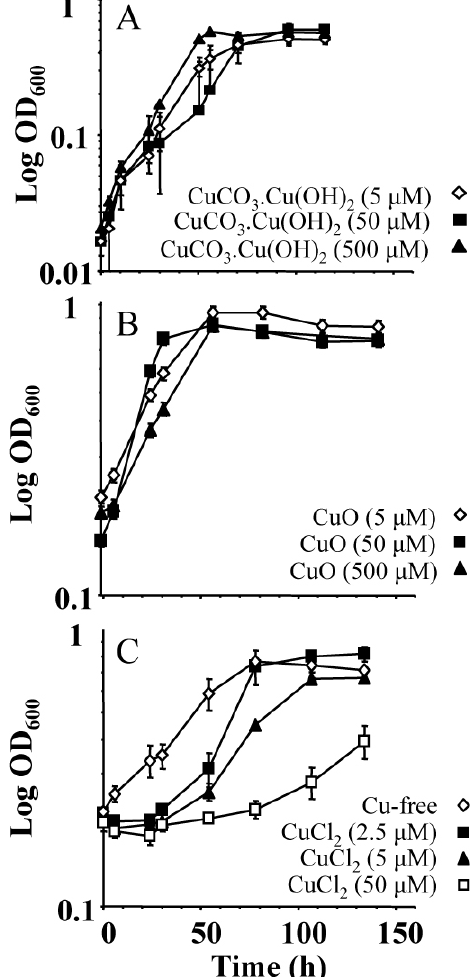
Fig. 1. Effect of Cu source and concentration on the growth of Methylosinus trichosporium OB3b. Error bars represent standard deviations ( n =